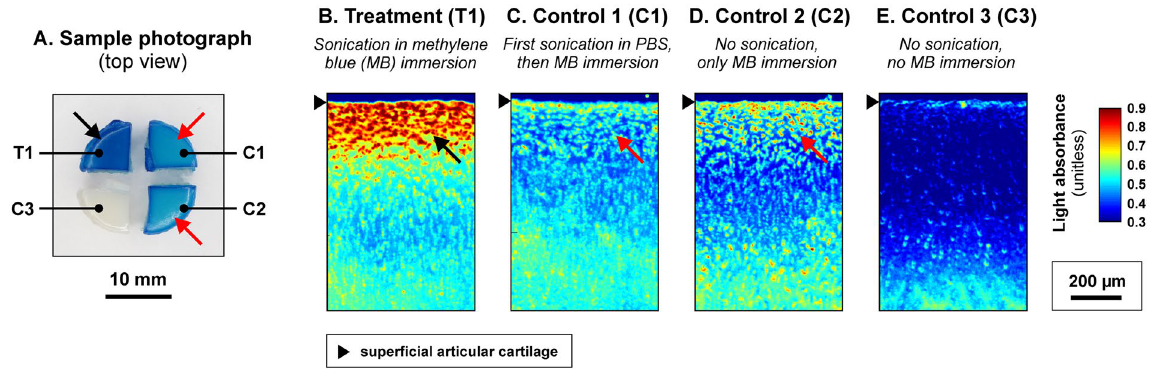
Figure 3. Photographs of treated sample quadrants ( A ) and optical absorbance images of articular cartilage (AC) samples ( B – E ) exposed to methylene blue (MB). The blue contrast in photograph and absorbance in AC sections were greater in T1 (black arrows) as compared to C1 and C2 (red arrows). No difference in absorbance was observed between C1 to C2 suggesting that ultrasound treatment does not modify permeability of AC.